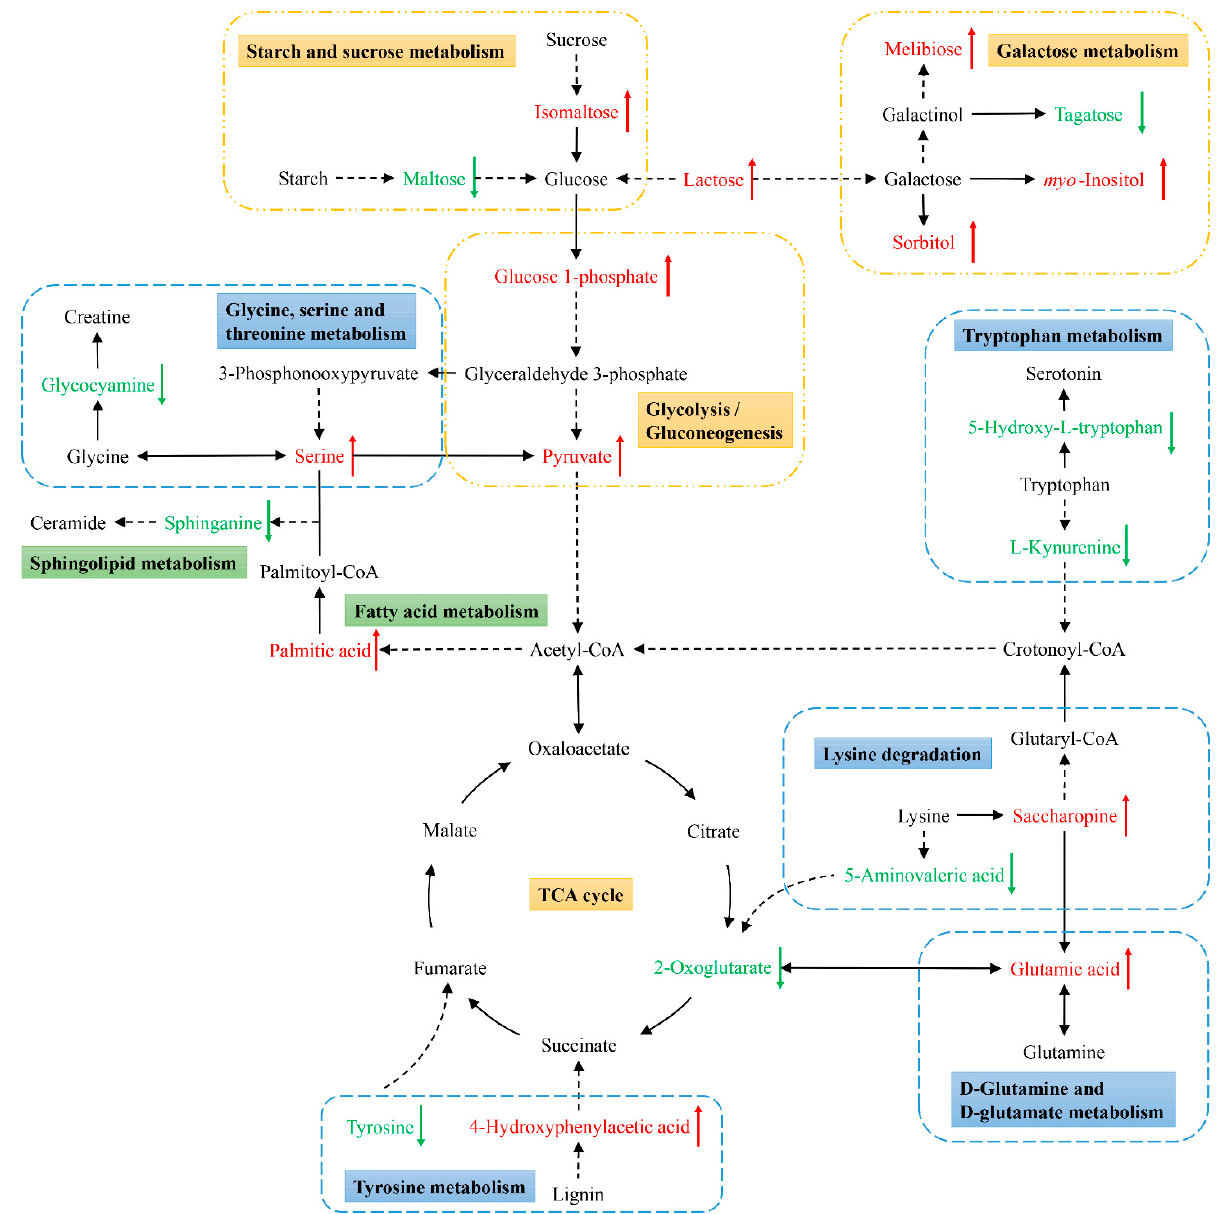
Figure 5. Schematic overview of the primarily affected metabolic pathways in C. formosanus workers. The red characters indicate metabolites that were highly abundant in termites fed a M. micrantha leaves diet, while green ones indicate metabolites that were highly abundant in termites fed a pinewood diet. Solid and dotted line arrows indicate direct and indirect reactions, respectively.